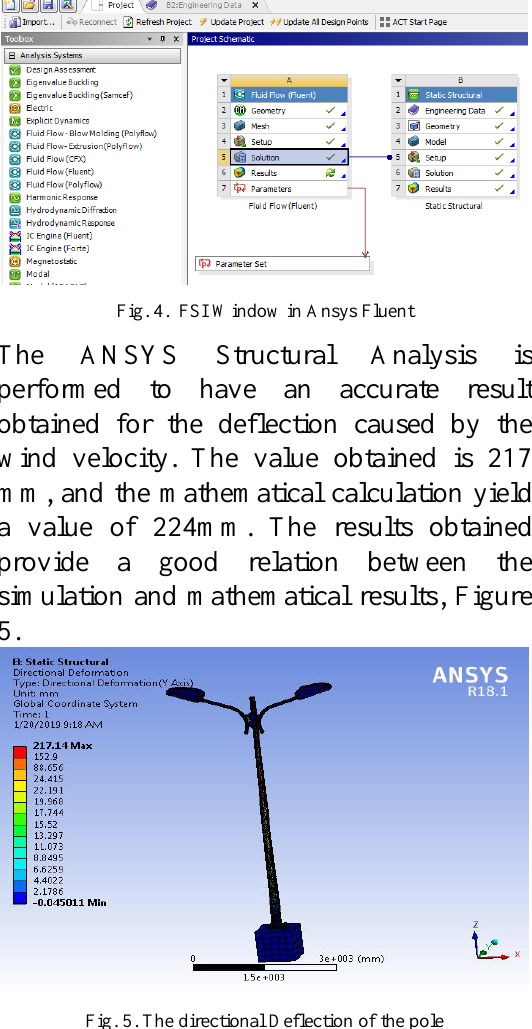
Fig. 5. The directional Deflection of the